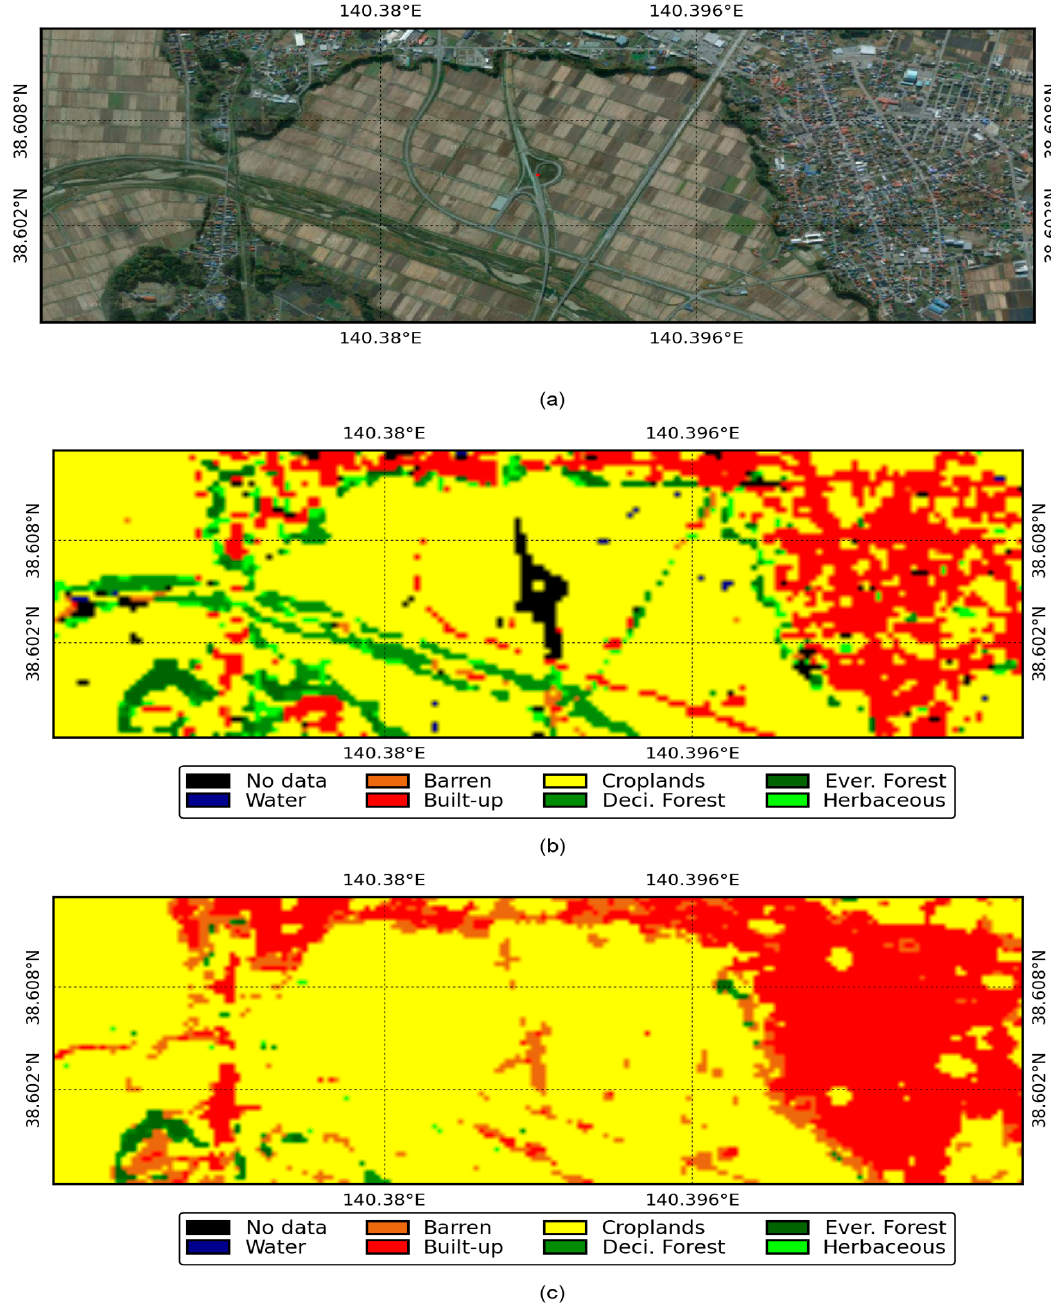
Figure 12. Performance of the JpLC-30 map over the JHR LULC map: ( a ) Google Earth™ image; ( b ) JHR LULC map; ( c ) JpLC-30 map.